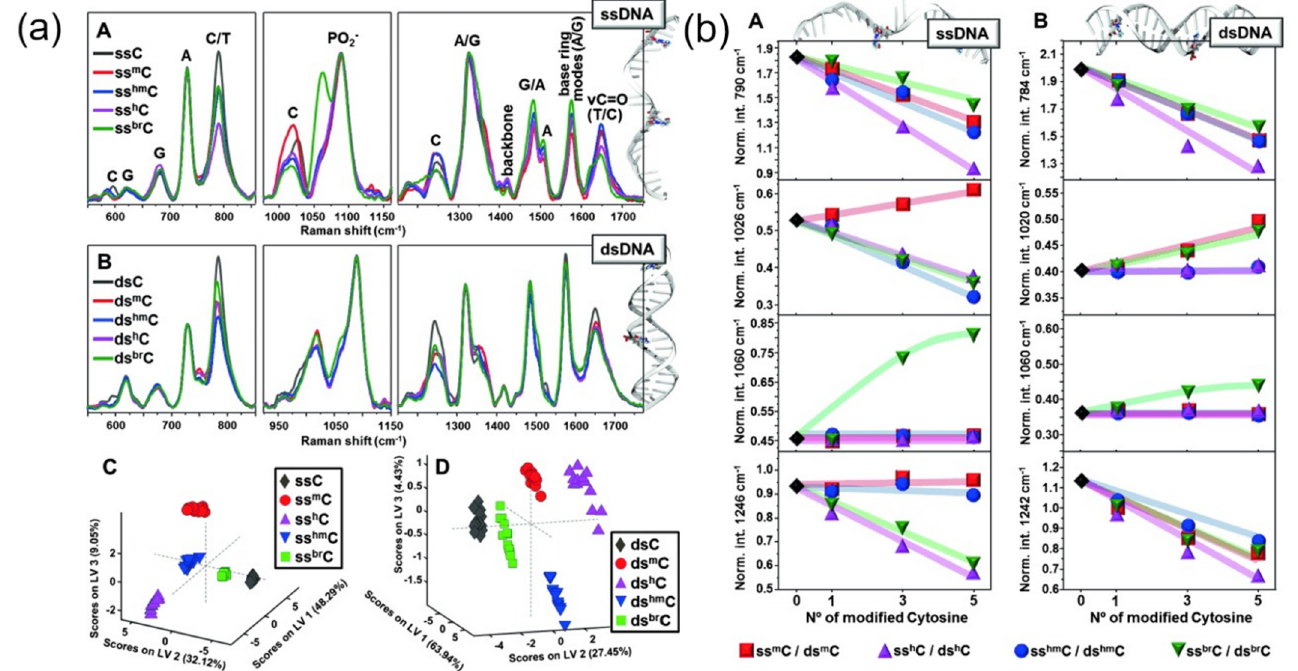
Figure 7. ( a ) Normalized SERS spectra of ( A ) single-stranded and ( B ) double-stranded sequences with different cytosine variations. ( C , D ) Partial least squares discriminant analysis of the recorded SERS spectra. ( b ) The relative SERS intensity of C spectral marker band was compared as a function of the content of nuclear base variants. ( a , b ) Reproduced with permission of Ref. [56] , Copyright 20195, Wiley-VCH Verlag GmbH & Co.